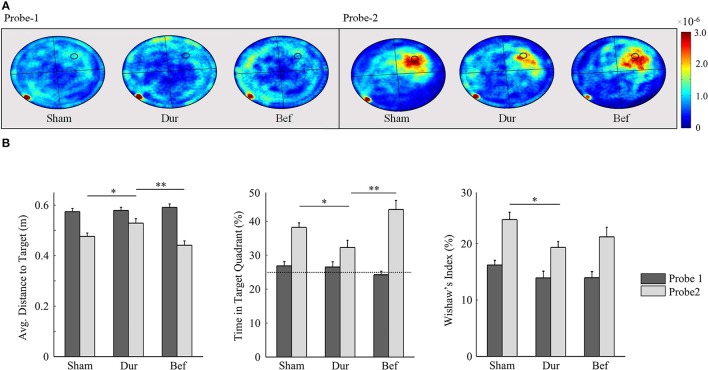
Rat swim paths during the probe sessions are represented as group-normalized 2D-histograms (A). The platform position (during acquisition) is indicated as a small circle in the goal quadrant (NW). All rats had demonstrated an ability to learn the task, as shown by an increased activity in the NW quadrant during the second probe session, as compared to chance-level (25%). The mean distance to the target (B-left), the % time in the target quadrant (B-center), and the Whishaw's Index (B-right) are shown for both probe sessions. *P < 0.05; **p < 0.01.